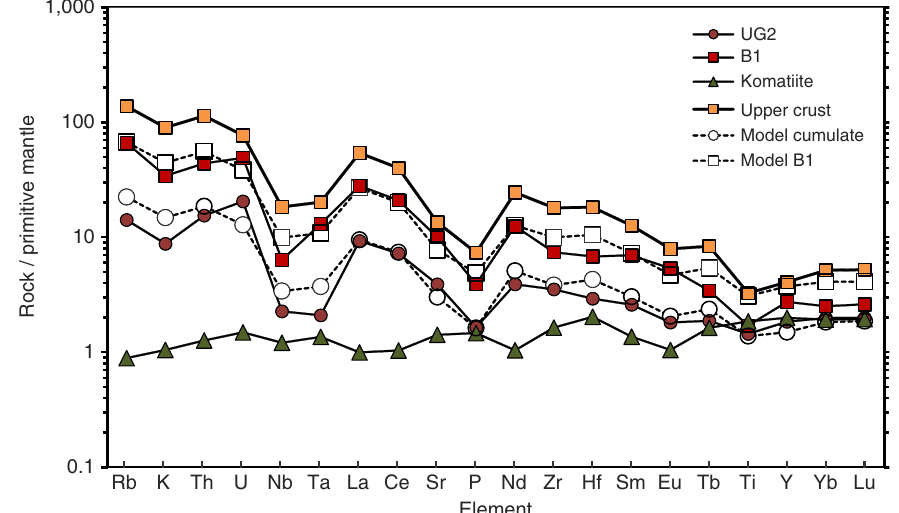
Figure 8 | Primitive mantle-normalized trace element concentrations for natural and model rocks from the Bushveld Complex. Solid symbols joined by solid lines represent rock analyses; upper crust 44 average B1 magma 37 , weighted average of UG2 in hole TF3, komatiite sample NXMW43-3 (ref. 43). Open symbols joined by dashed lines represent alphaMELTS 40–42 models. Model cumulate is 75% solids þ 25% liquid; model B1 is 25% solids þ 75%